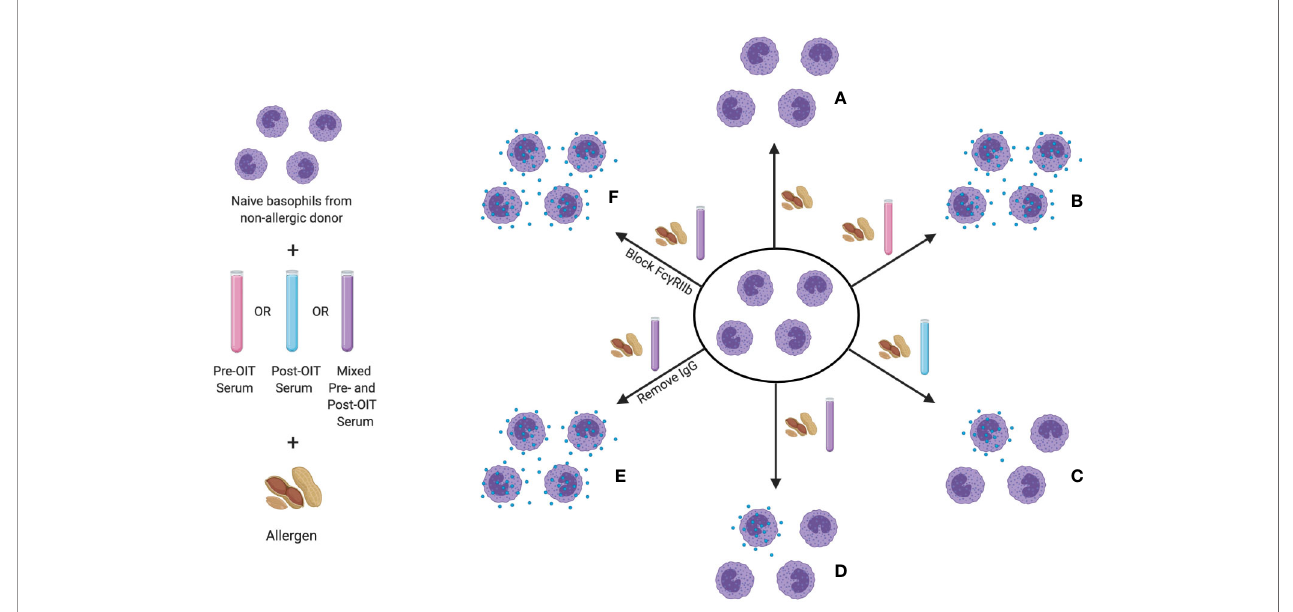
FIGURE 3 | The indirect basophil activation test (iBAT) as a probe for inhibitory food allergen speci fi c IgG. In this assay, basophils from a non-allergic donor are sensitized with IgE from an allergic donor, then incubated with serum to be queried (typically pre-OIT serum, post-OIT serum, or a mix of the two) and then exposed to allergen. Conditions assayed include (proceeding clockwise starting from top center): (A) basophil incubation with allergen in the absence of serum (no activation), (B) with serum from an allergic donor (full degranulation), (C) with post-OIT serum (suppressed activation), (D) with a mix of pre- and post-OIT serum (suppressed activation if inhibitory activity is present), (E) post-OIT serum with IgG removed (to query the contribution of IgG to suppression) and (F) post-OIT serum with antibodies to Fc g RIIb (to test whether inhibition is